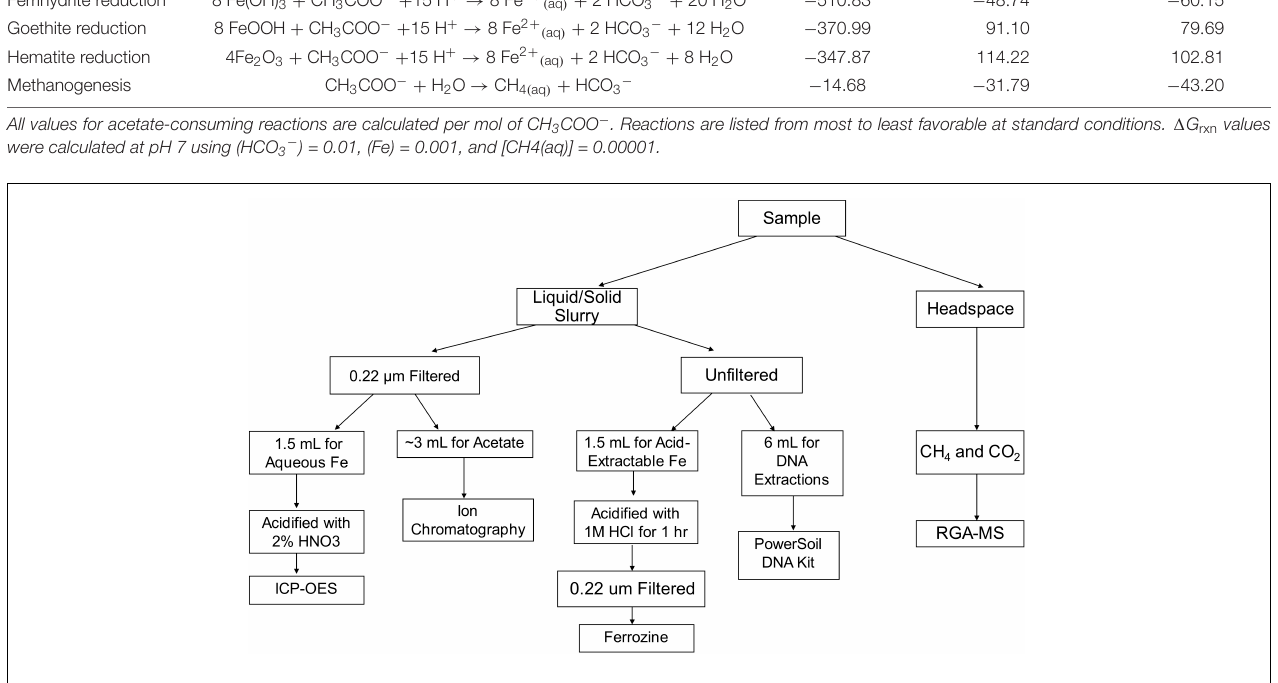
FIGURE 1 | Visual representation of sampling protocol and